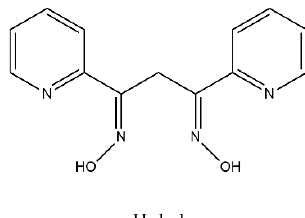
Figure 23. The free ligand 1,3-di(pyridin-2-yl)propane-1,3-dione dioxime which has been used for the synthesis of a covalently linked dimer of {Mn III 3 } SMMs.